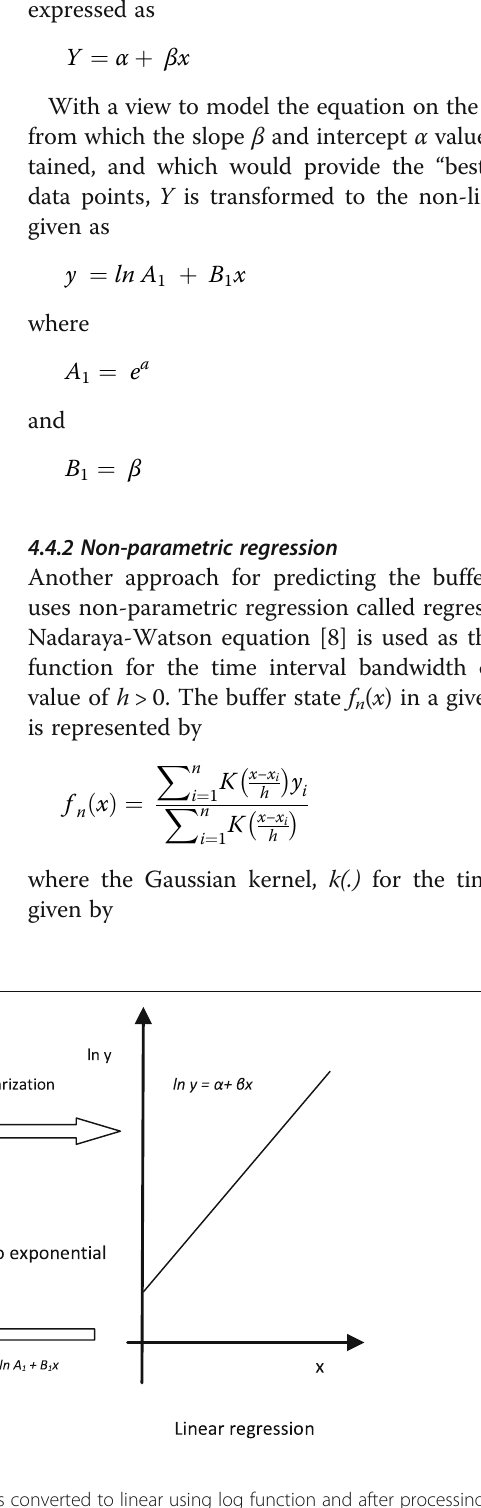
Fig. 5 Transformation of regression domain. The non-linear regression is converted to linear using log function and after processing converted back to